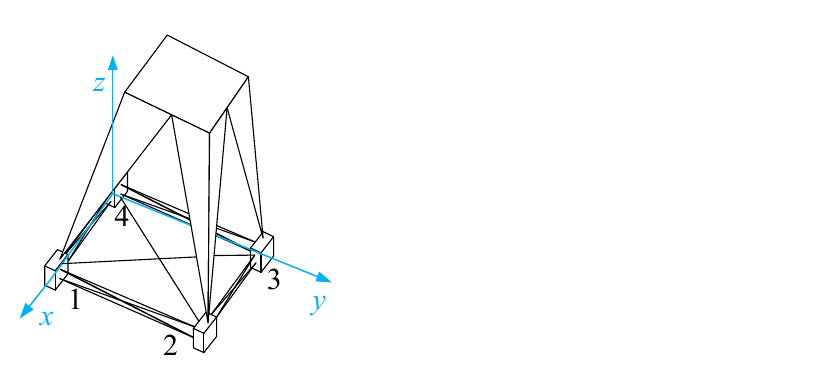
Figure 11. Schematic diagram of the stressed structure of the reinforced pylons.